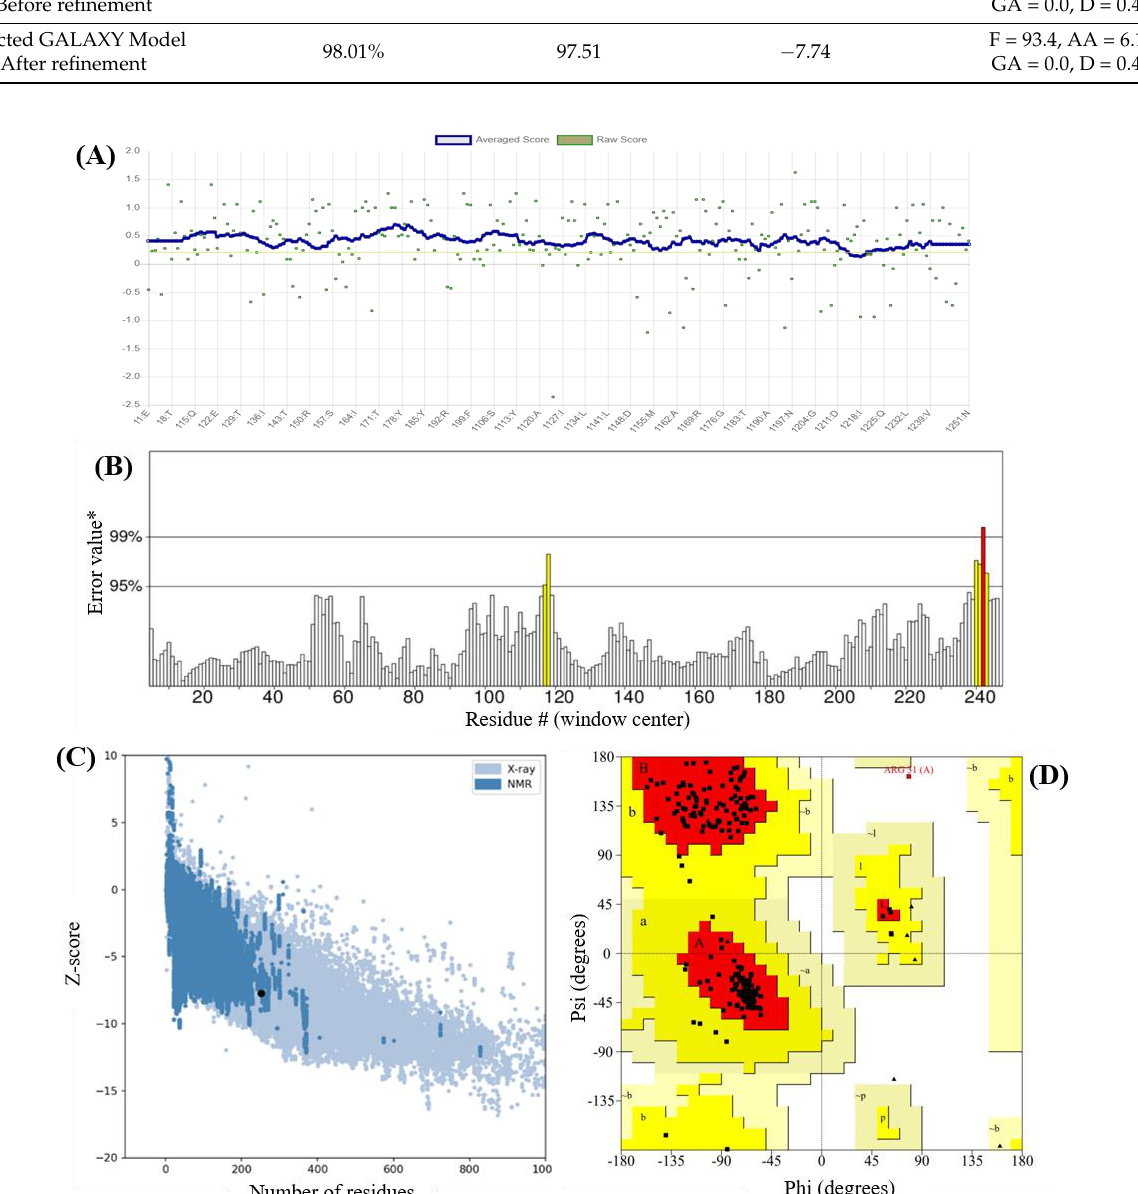
Figure 2. Final model validation scores. ( A ) Verify 3D Plot showed 98.01% of the residues had an averaged 3D–1D score ≥ 0.2. ( B ) ERRAT plot reported 97.51 overall quality factor. Residues having an error value of less than 95% are in a desirable protein structure. Yellow and red lines represent portions of the 3D model that may be rejected at 95%and 99% confidence thresholds, respectively. ( C ) ProSA–web of final model earned a Z–score of − 7.74. ( D ) Ramachandran plot represented 93.4% in favored (red), 6.1% in additionally allowed (yellow), and